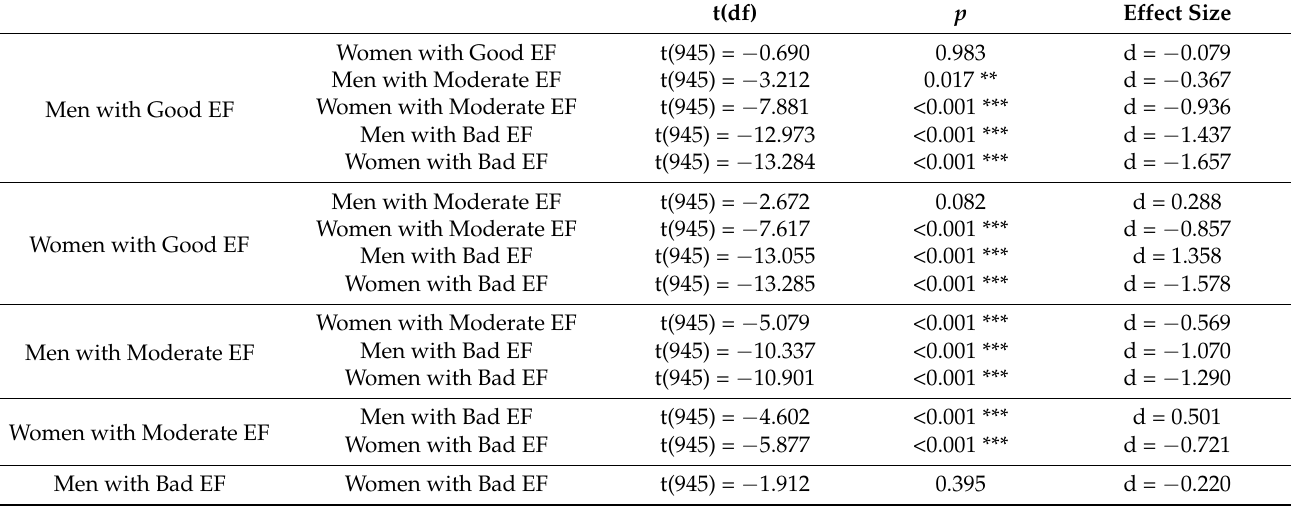
Table 3. A t-test analysis . Differences in state anxiety between sexes, according to the level of executive